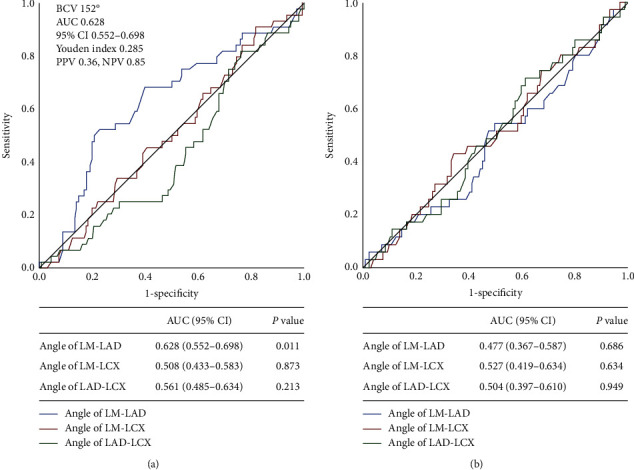
Receiver operating characteristic curves showing sensitivity of each angle for predicting TLF risk in patients treated with (a) crush and (b) T-stenting technique. An LM-LAD angle of 152° was the best cutoff value for predicting TLF in the crush group. None of the bifurcation angles had a significant cutoff value in the T-stenting group. AUC, area under the curve; BCV, best cutoff value; CI, confidence interval; LAD, left anterior descending artery; LCX, left circumflex artery; LM, left main; TLF, target lesion failure.